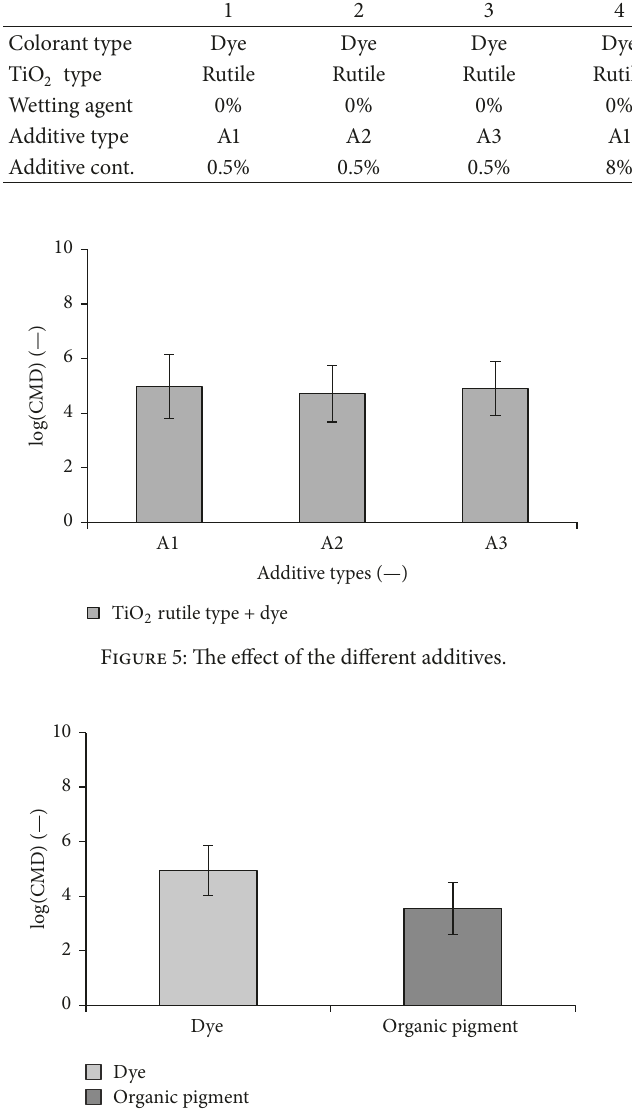
Figure 6: The effect of colorant type.